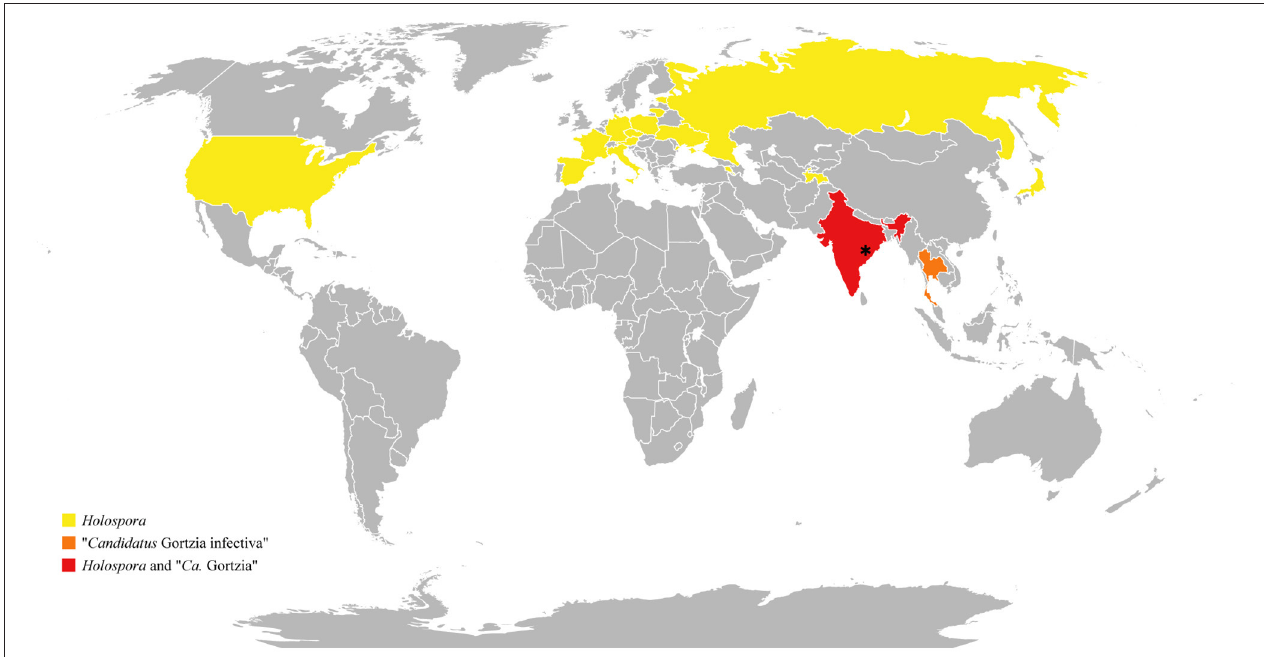
FIGURE 7 | Holospora -like bacteria distribution. Yellow, orange, and red indicate countries in which Holospora -like bacteria have so far been detected, whereas a gray indicates those areas not yet investigated for their presence. Asterisk indicates sampling area of Holospora obtusa and “ Ca. Gortzia” species characterized in the present